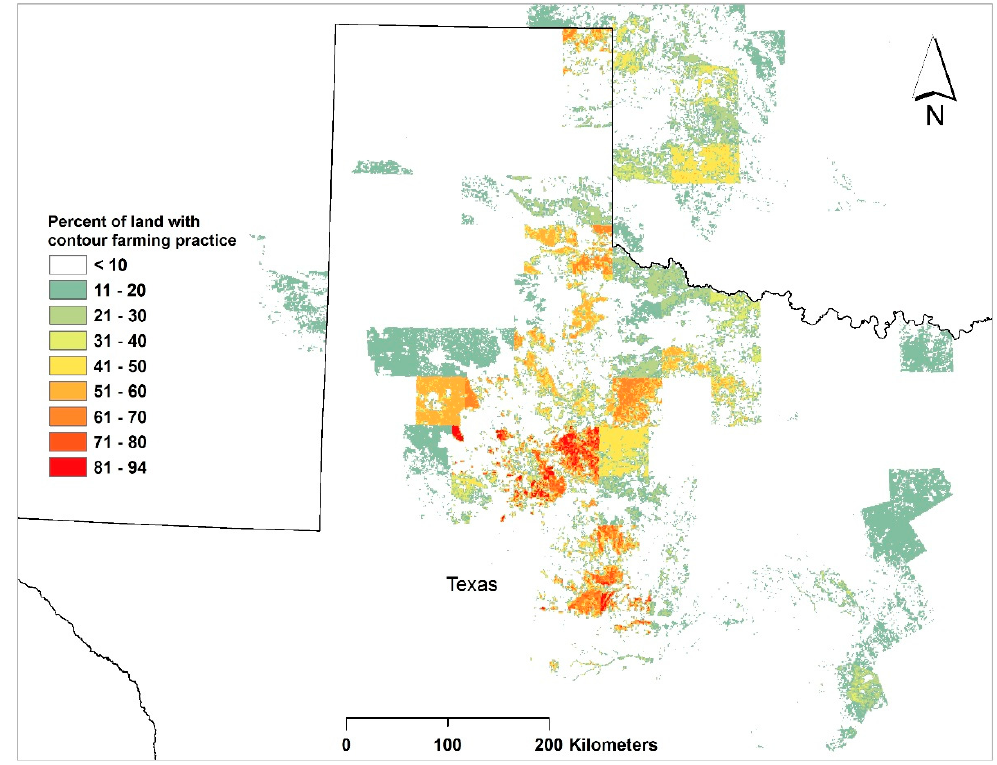
Figure 2. Percentage of land with contour farming practice (Conservation Practice 330) in northwestern Texas and surrounding regions (Data from Reference [20]).